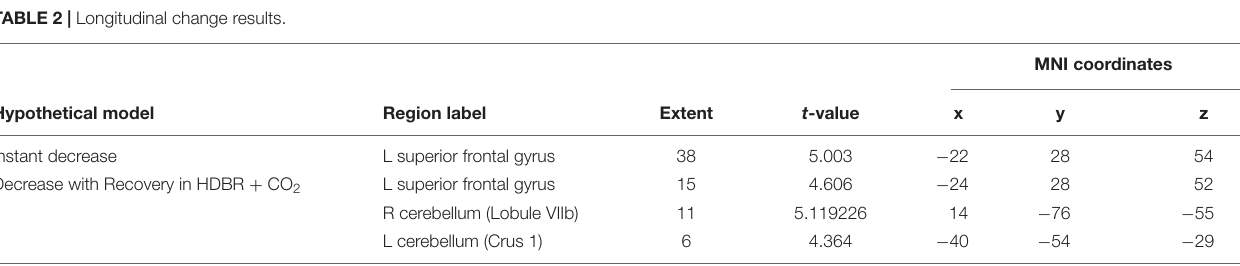
FIGURE 5 | Longitudinal change in DTCost of brain activation associated with HDBR + CO 2 . (Top Left) Hypothesized models of longitudinal instant change (orange) and instant change with recovery in-HDBR (green). (Top Right) Exhibited pattern of longitudinal DTCost of brain activation change in the left superior frontal gyrus (blue). Analyses were conducted at an uncorrected alpha level of p < 0.0001. (Bottom) Left superior frontal gyrus cluster that showed significant longitudinal change associated with HDBR + CO 2 . TABLE 2 | Longitudinal change